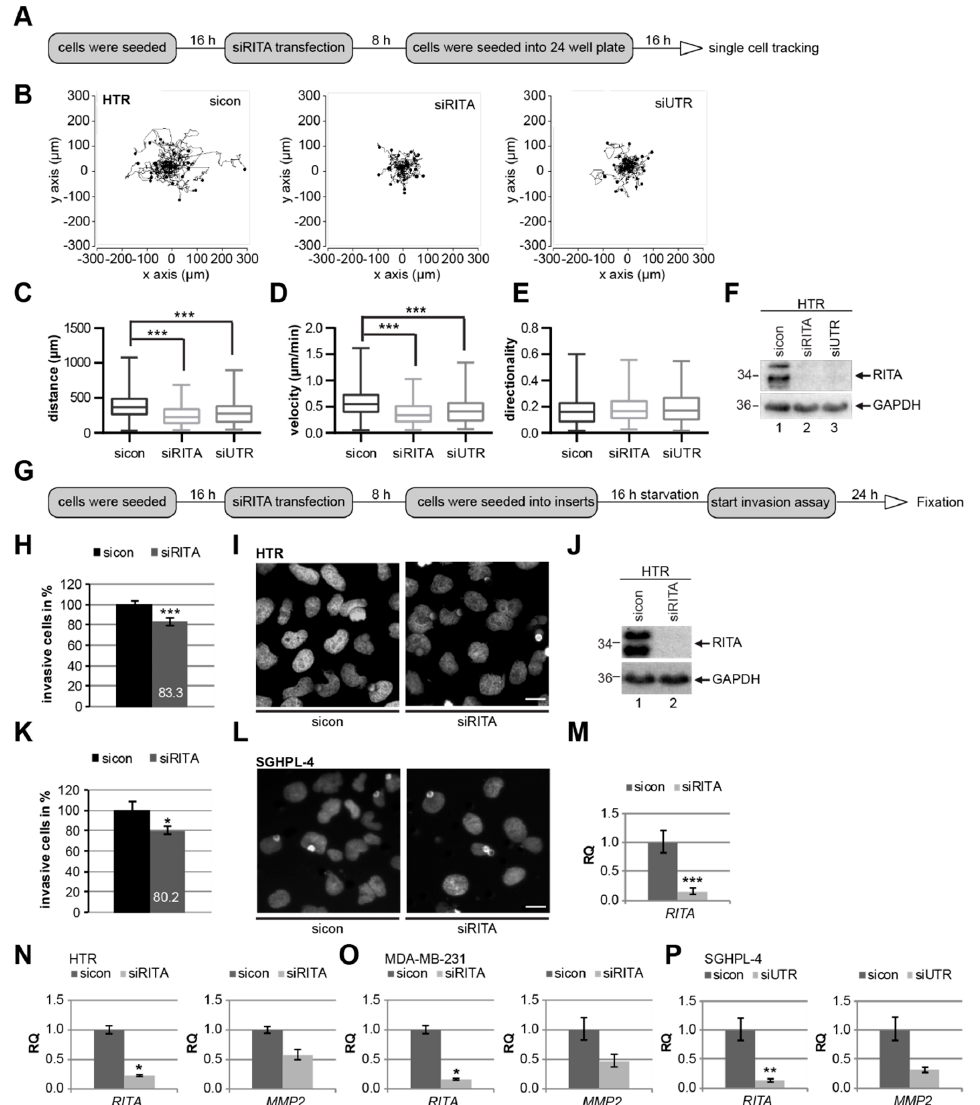
Figure 4. RITA is required for cell motility and invasion of trophoblastic cells. ( A ) Working schedule for time-lapse microscopy. HTR cells were treated with control small interfering RNA (siRNA) (sicon), siRNA against the coding region of RITA (siRITA), or its untranslated region (siUTR) for time-lapse microscopy to analyze their random motility. ( B ) Representative trajectories of individual cells ( n = 30) are shown. ( C – E ) Results of the accumulated distance ( C ), velocity ( D ), and directionality ( E ) are presented as box and whisker plots with minimum and maximum variations. Mann–Whitney U test, *** p < 0.001. ( F ) Control Western blot analysis was performed. GAPDH was used as loading control. ( G ) Working schedule for invasion assay. After seeding siRNA-treated cells (sicon or siRITA) into transwell systems, they were starved for 16 h. Then they were released into fresh medium for 24 h and fixated. ( H ) Invasion assay of HTR cells. The total number of invaded sicon cells was assigned as 100%. The results from three individual experiments are presented as mean ± standard error of the mean (SEM). Student’s t -test, *** p < 0.001. ( I ) Representative images of invaded HTR cells are shown. Scale: 20 μ m. ( J ) Control Western blot analysis was performed. GAPDH served as loading control. ( K ) Invasion assay of SGHPL-4 cells. The total number of invaded sicon cells was assigned as 100%. The results from four independent experiments are presented as mean ± SEM. Student’s t -test, * p < 0.05. ( L ) Representative images of invaded SGHPL-4 cells are shown. Scale: 20 μ m. ( M ) Gene analysis